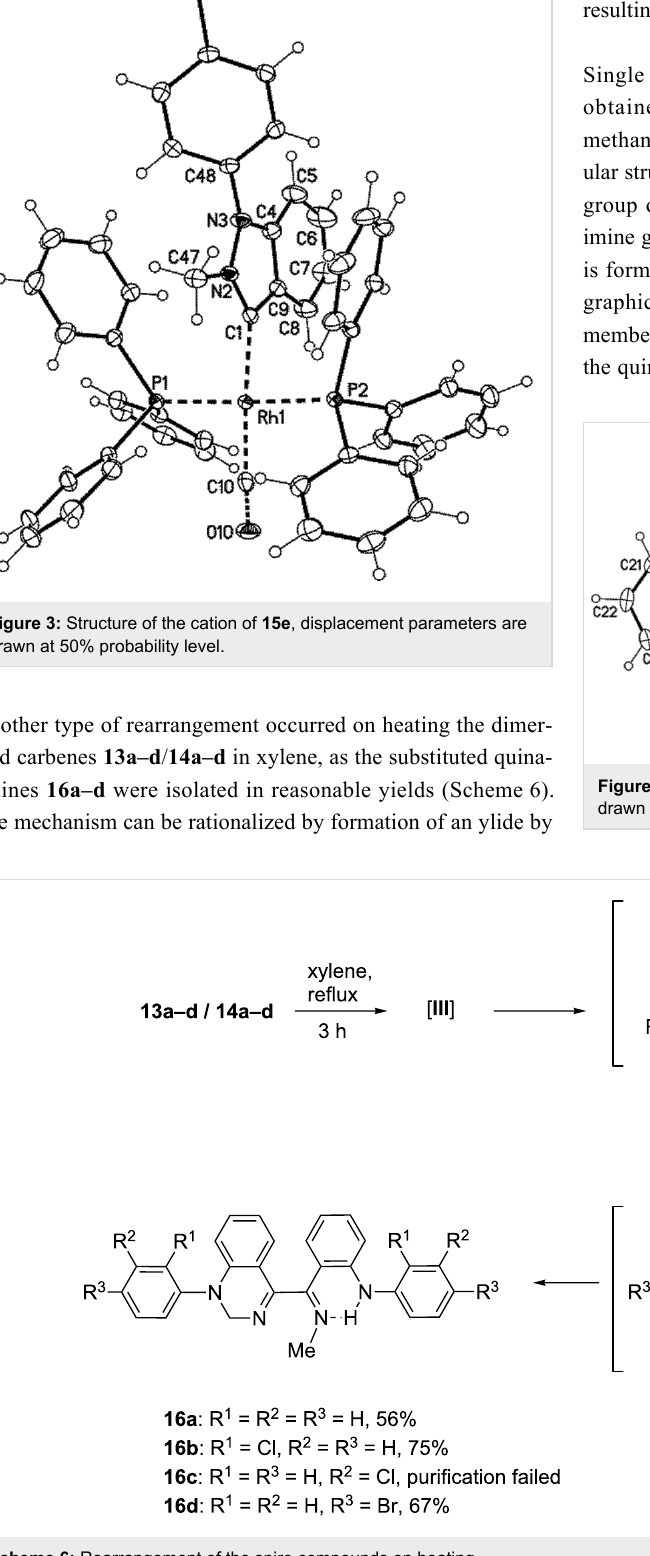
Scheme 6: Rearrangement of the spiro compounds on heating.